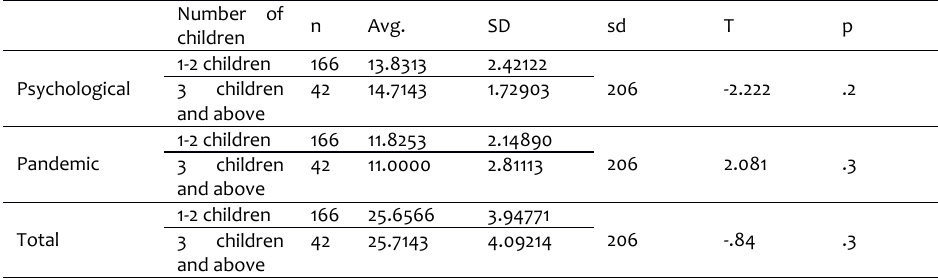
Table 4. The mean scores and t-test results of the reactions of the children to the pandemic according to the number of children of the parents (n=208) Number of n Avg. children